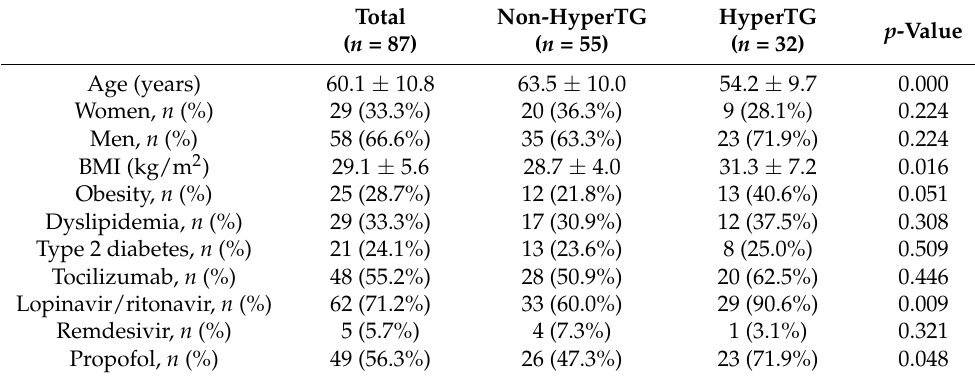
Table 1. Population characteristics.